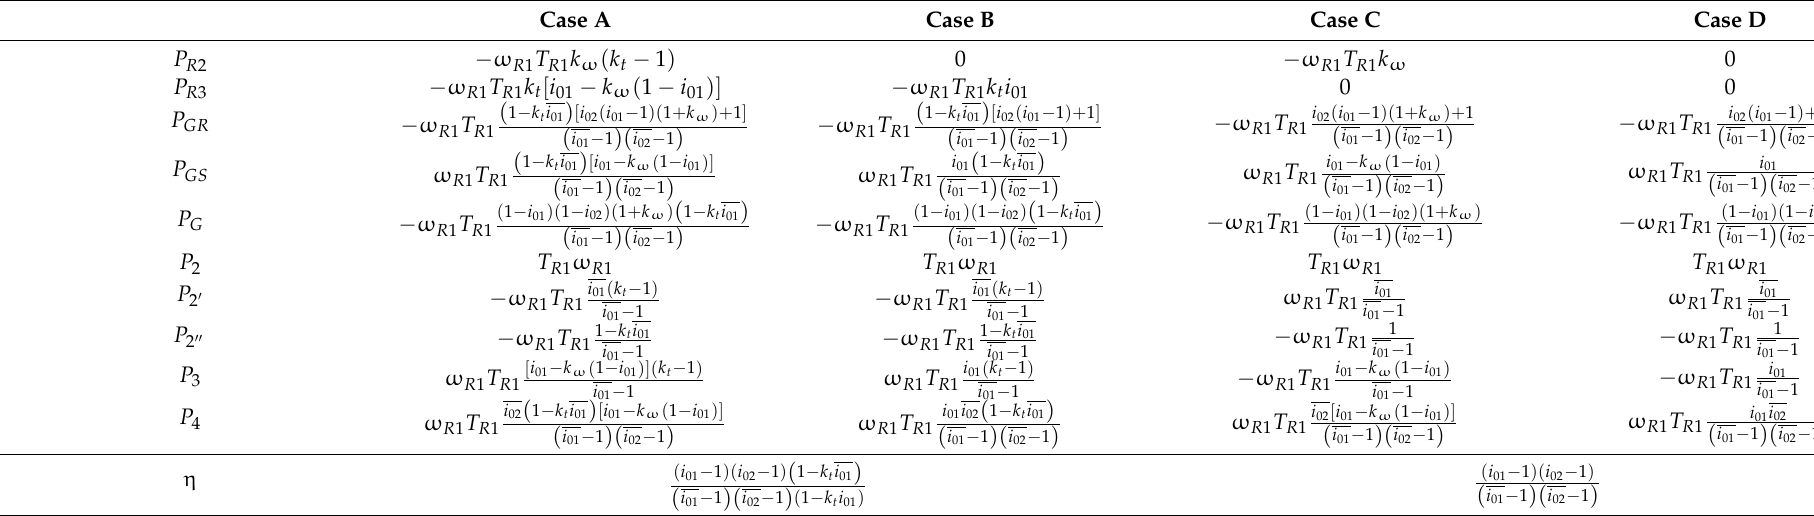
Table 3. WSCG power and efficiency expressions for the four cases (Figures 1 and